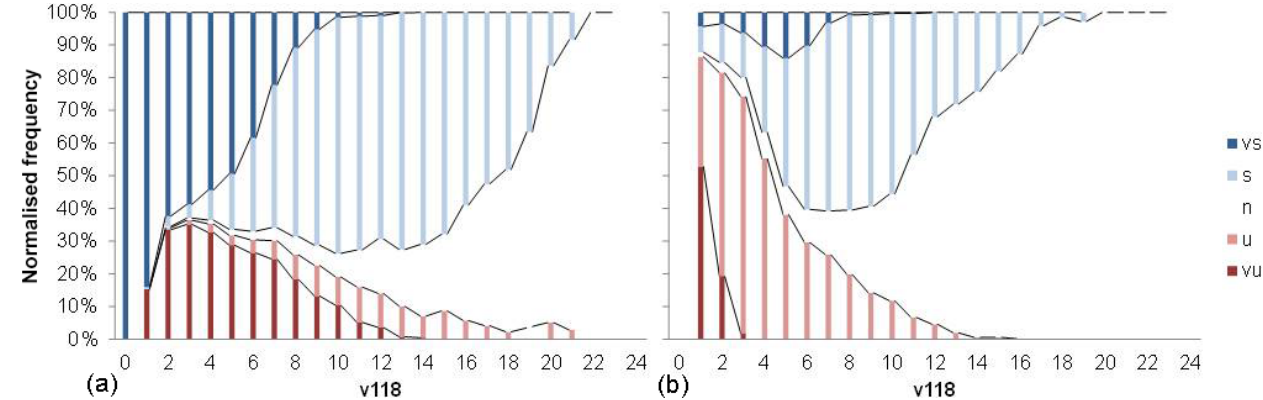
Figure 12. Distribution of atmospheric stability with wind speed (a) based on Ri b and (b) based on z/L obtained from Ri b with transforma- tion functions by Businger and Dyer. vs, very stable; s, stable; n, neutral; u, unstable; vu, very unstable. Table 5. Frequency of occurrence of stability classes.